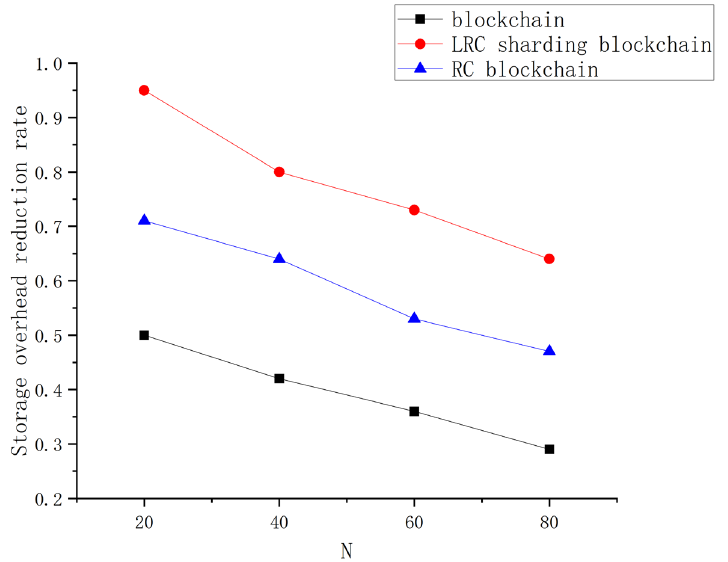
Figure 6. Reduction rate of storage overhead.